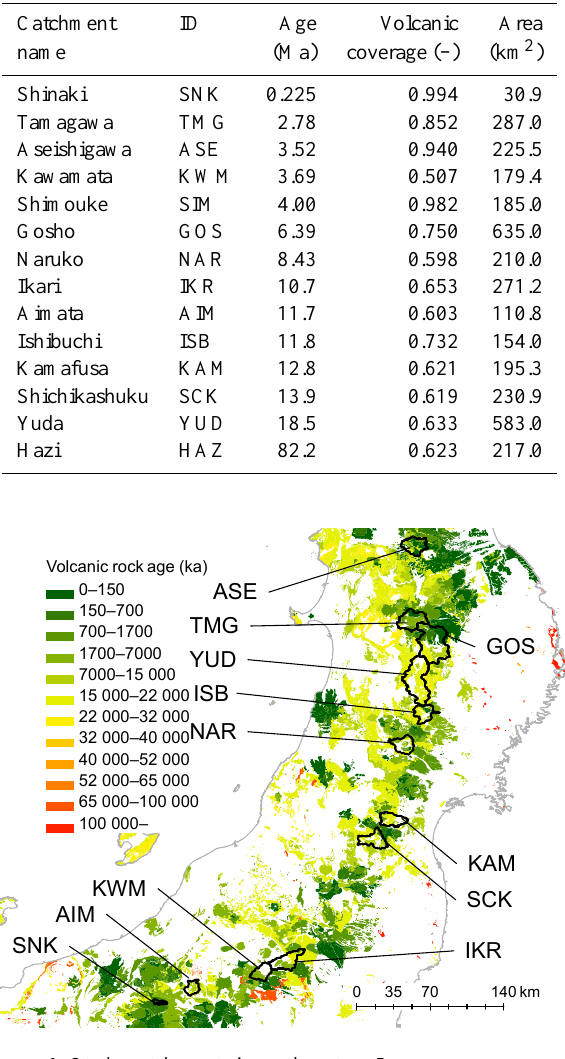
Table 1. List of study catchments